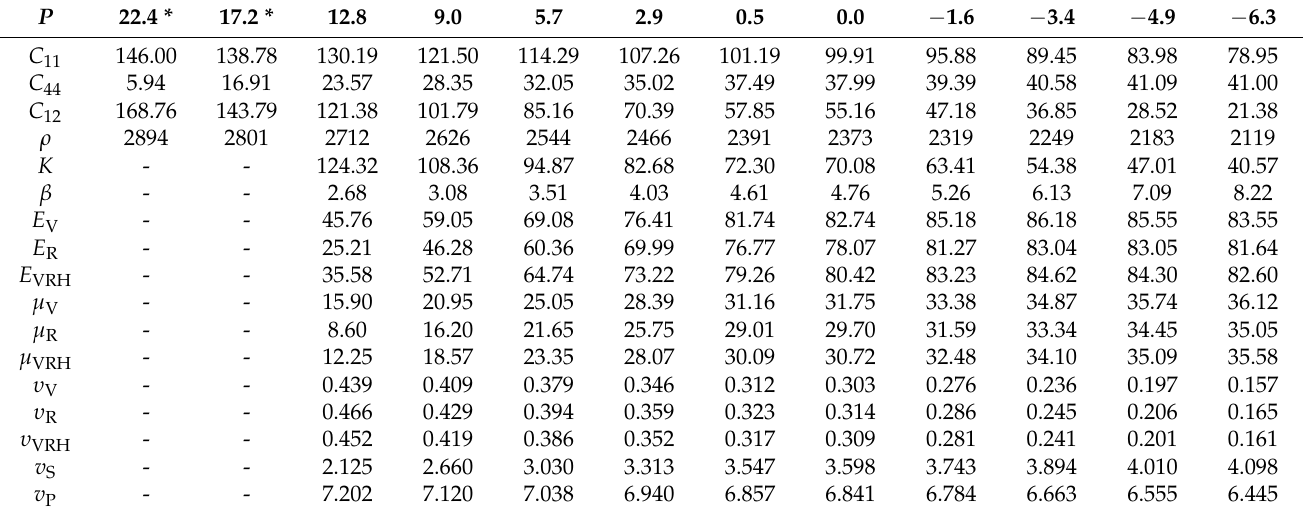
Table 3. Elastic moduli C ij (GPa), density ρ (kg m − 3 ), bulk modulus ( K , GPa), linear compressibility ( β , TPa − 1 ), Young’s modulus ( E , GPa), shear modulus ( µ , GPa), Poisson’s ratio ( υ ), and average longitudinal and shear wave velocities ( v P and v S , respectively), of sodalite as a function of pressure P